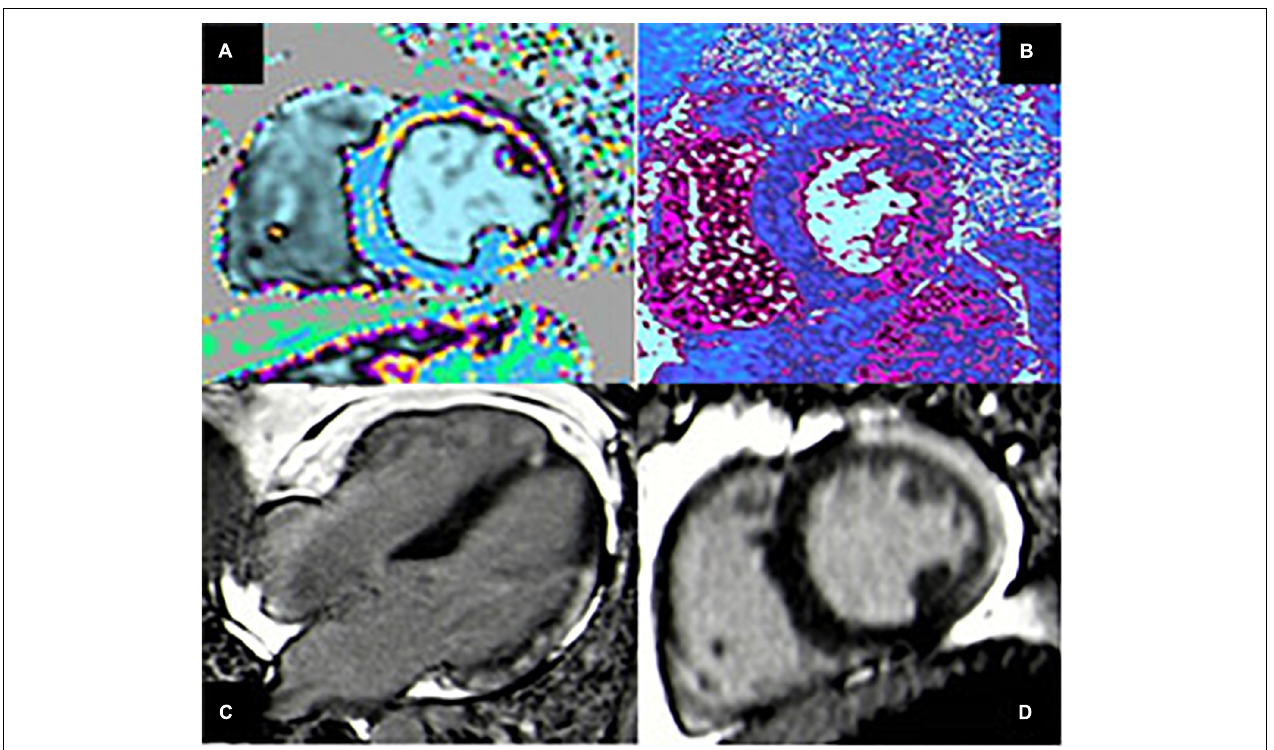
FIGURE 2 | Case of acute myocarditis. (A,B) T1 and T2 mapping show increased value of both parameters in the lateral wall compatible with myocardial edema. (C,D) Four-chamber and short-axis views showing subepicardial late gadolinium enhancement (LGE) with typical pattern in the infero-lateral